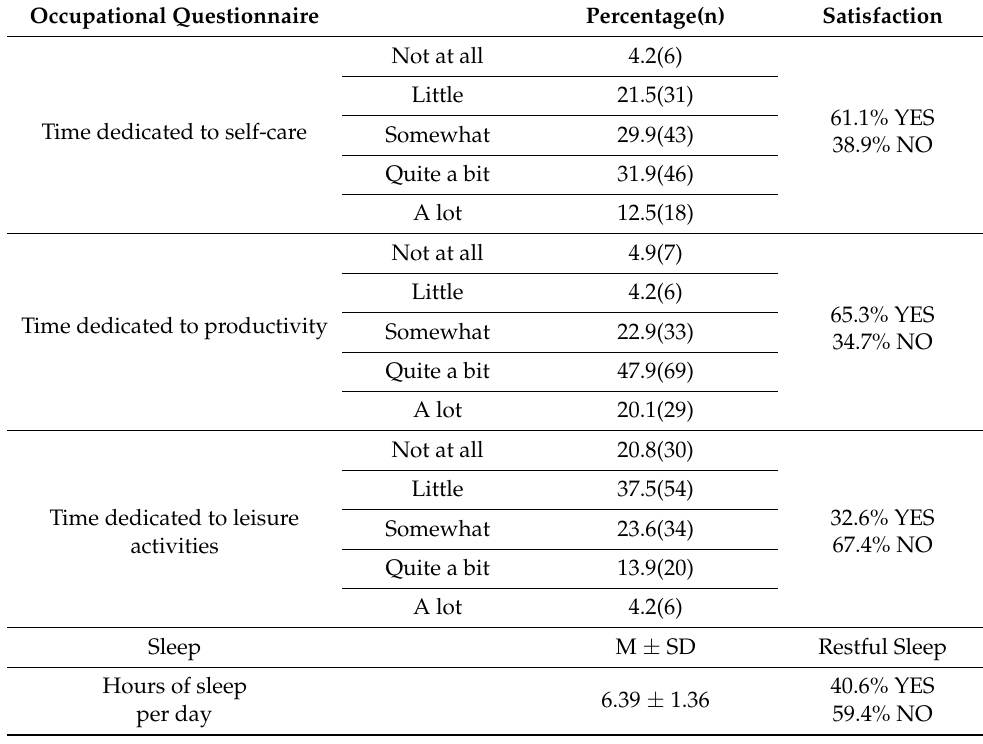
Table 2. Occupational performance questionnaire in caregivers.